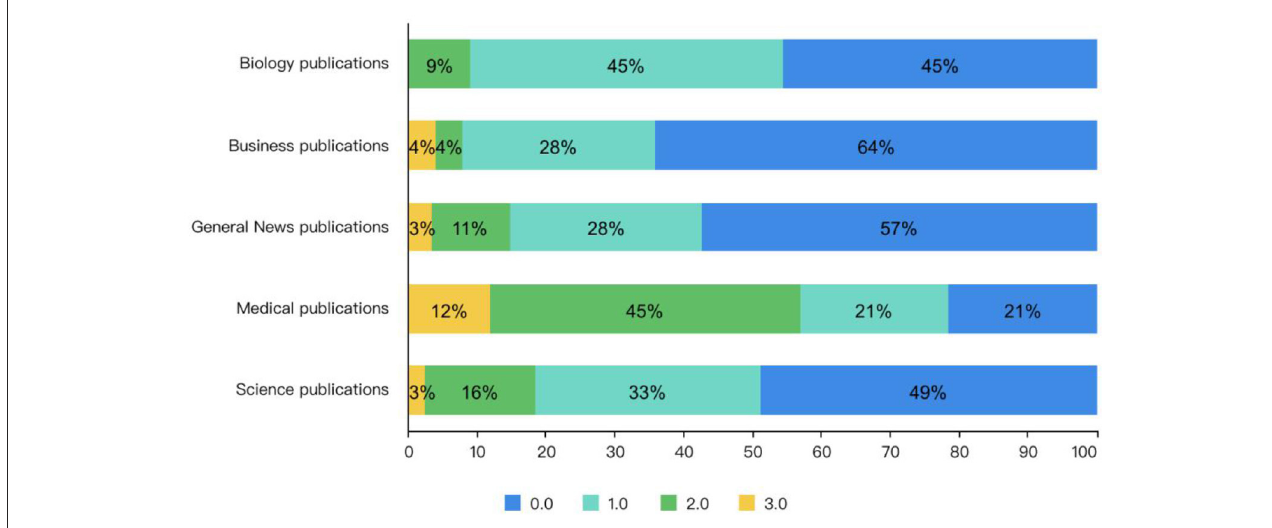
FIGURE6 Preprint frame adoption scores of different media